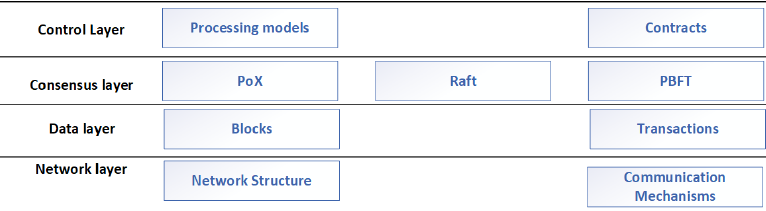
Figure 3. The Blockchain Architecture.